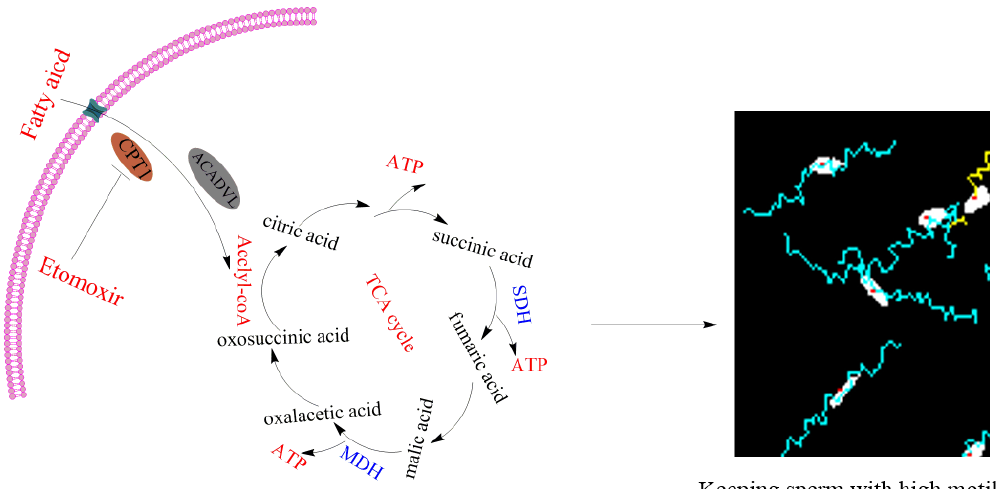
Figure 11. Mechanisms of β-oxidation involved in regulating boar sperm motility. Boar sperm could utilize the fatty acids to generate ATP via β-oxidation, thus maintaining sperm motility. MDH: dehydrogenase. SDH: succinate dehydrogenase. ATP: adenosine malate dehydrogenase. SDH: succinate dehydrogenase. ATP: adenosine triphosphate.